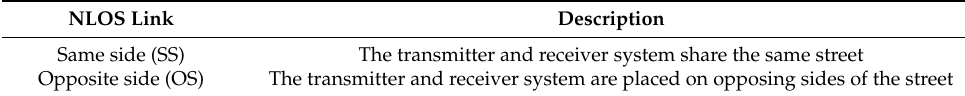
Table 1. Measurement Campaign non-line-of-sight (NLOS) Links.